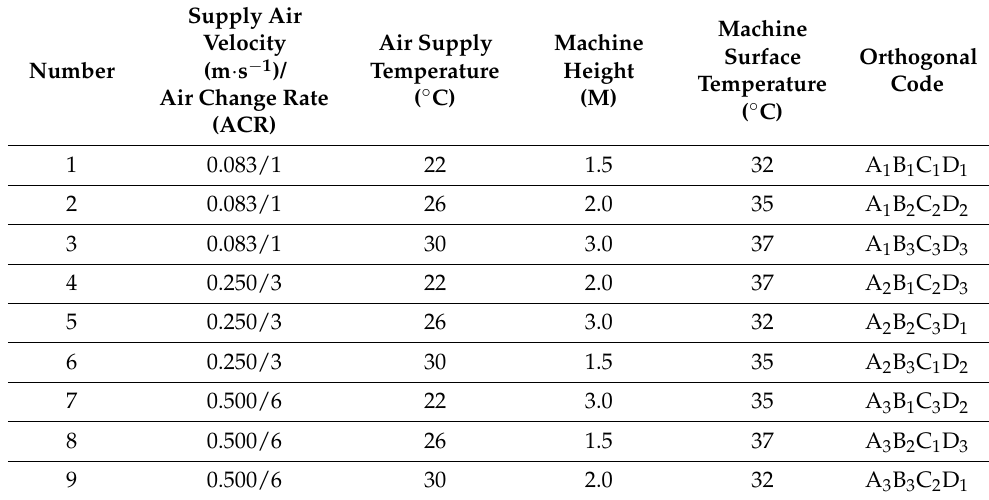
Table 3. Orthogonal experimental code